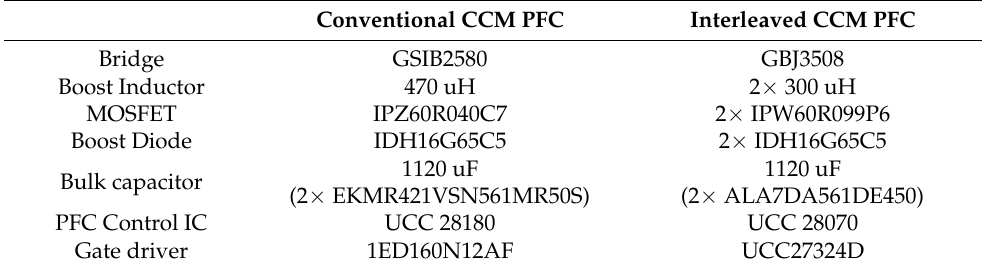
Table 3. Selection elements of the different topologies.